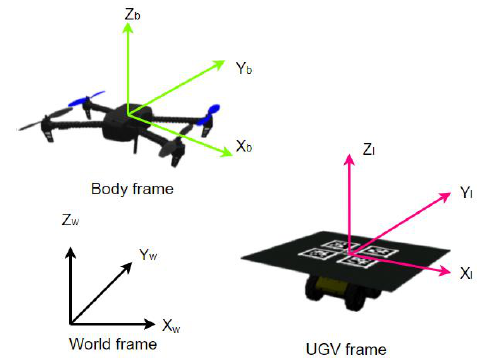
Figure 1. System overview and main coordinate frames.